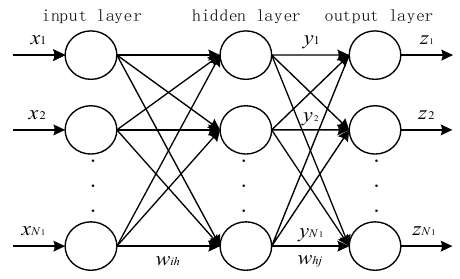
Figure 3. BP algorithm structure.